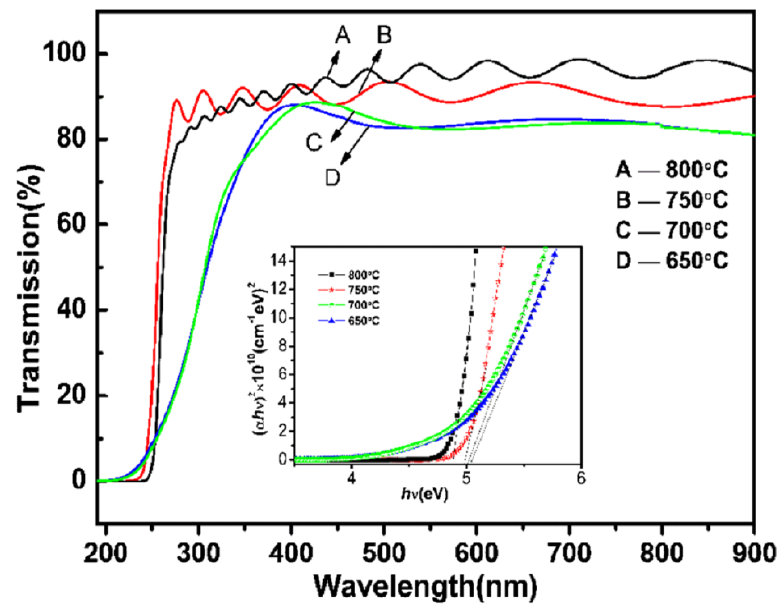
Figure 12. The band gap graph, plotted for beta gallium oxide at different temperatures grown using MOCVD. The graph is plotted using the Tauc plot theory [170]. “Reprinted with permission from Ref. [170]. Copyright (2017), SpringerLink”.